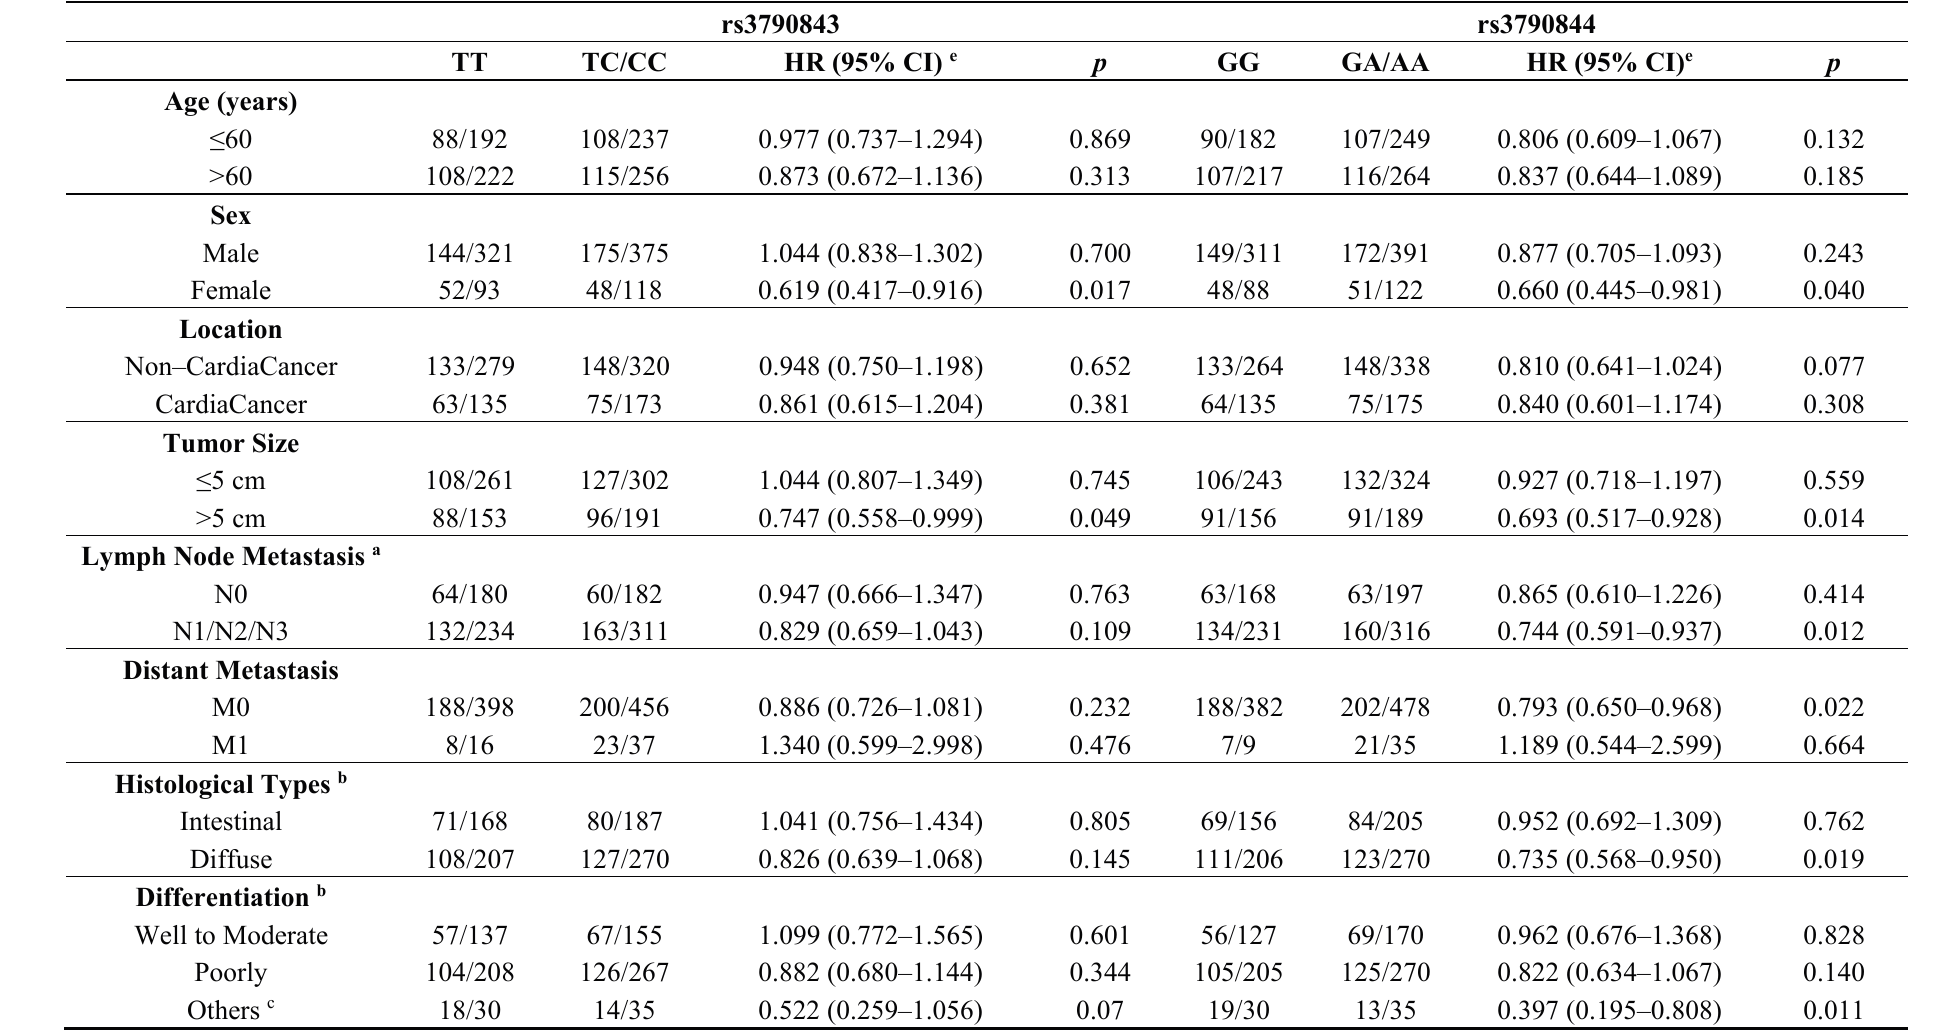
Table 5. Stratified analysis of rs3790843 and rs3790844 polymorphism among GC